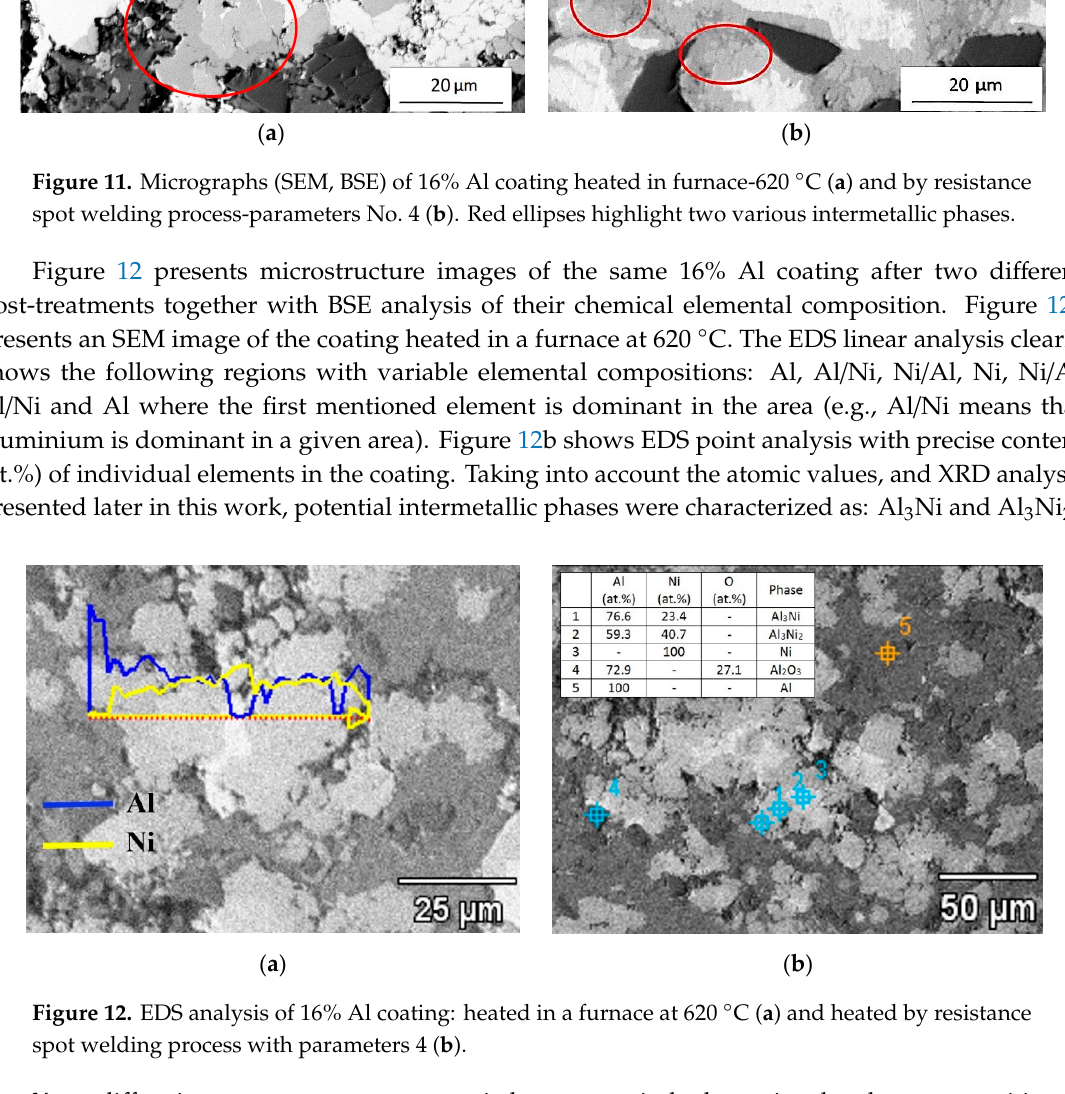
Figure 11. Micrographs (SEM, BSE) of 16% Al coating heated in furnace-620 °C ( a ) and by resistance spot welding process-parameters No. 4 ( b ). Red ellipses highlight two various intermetallic phases.